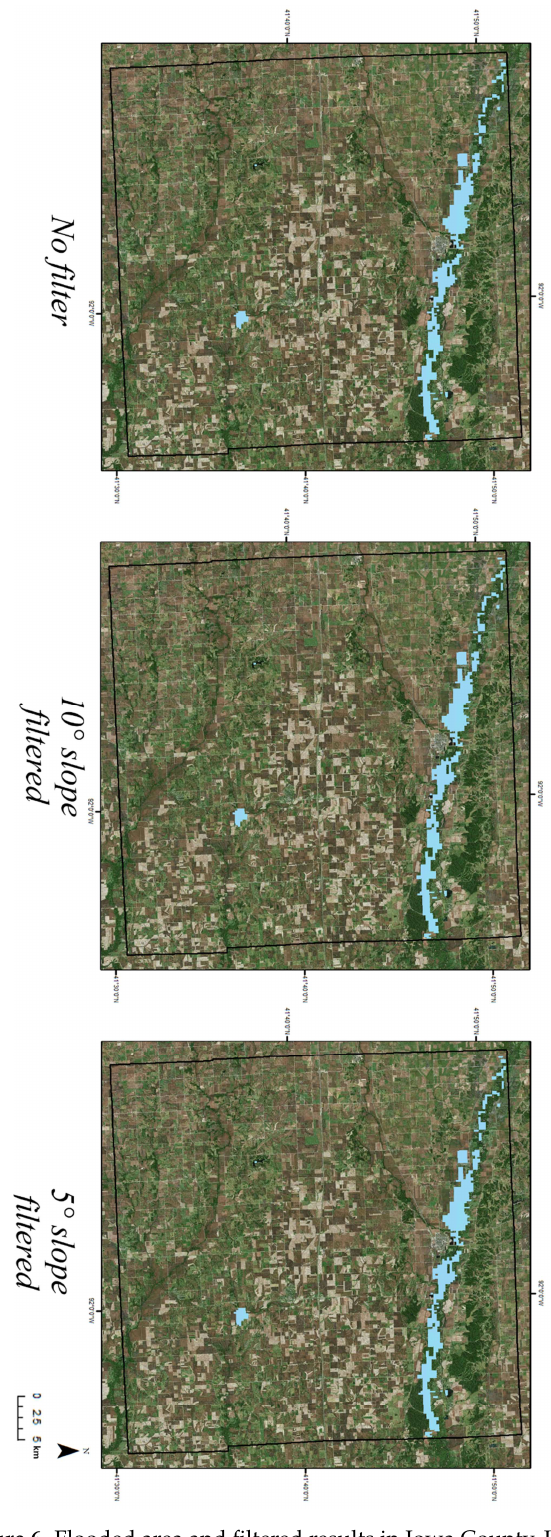
Figure 6. Flooded area and filtered results in Iowa County, Iowa.